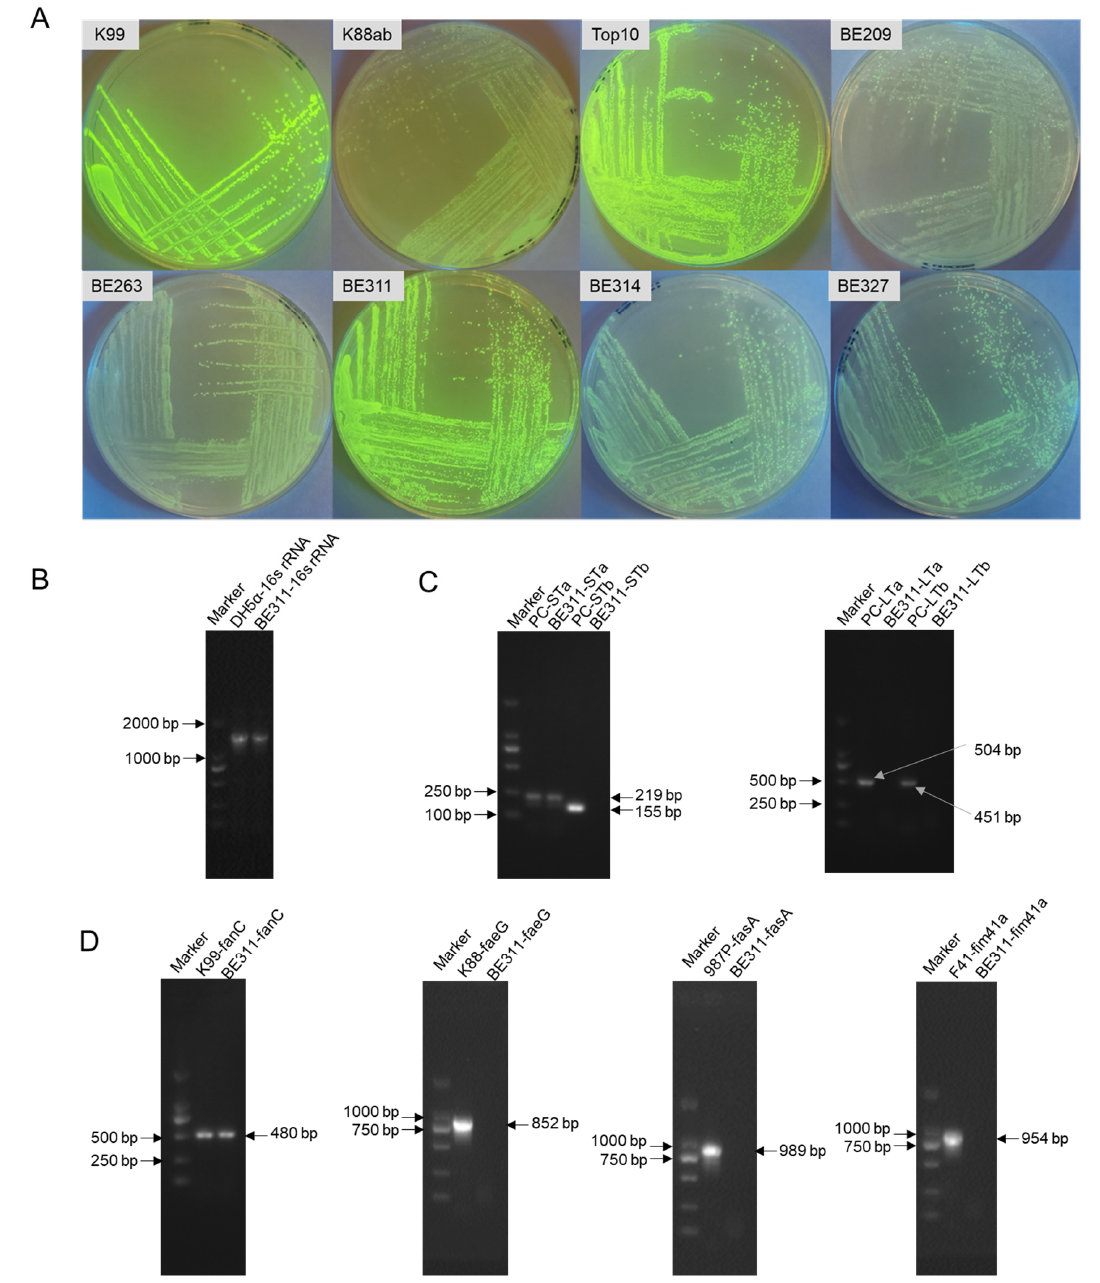
Figure 1 . Identification and characterization of E. coli BE311. ( A ), The expression of pQE30-GFP in different E. coil strains . ( B ), PCR amplification of the 16S rRNA of E. coli BE311. ( C ), Identification of the enterotoxins in E. coli BE311 by agarose gel electrophoresis (AGE). ( D ), Identification of the adhesions in E. coli BE311 by AGE.